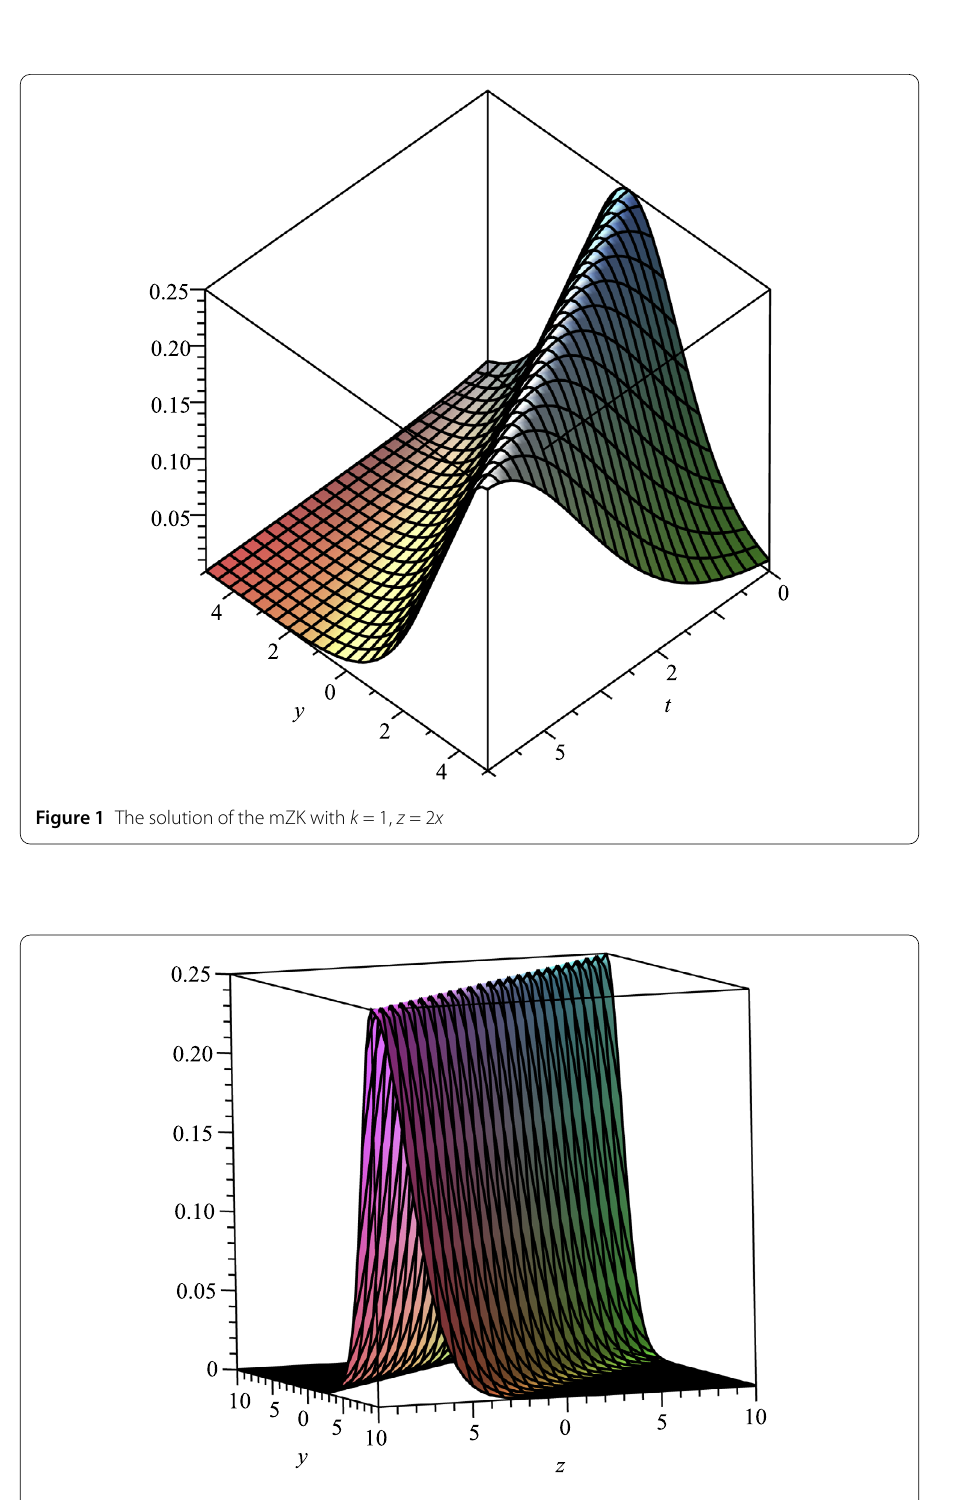
Figure 2 The solution of the mZK with k = 1, t = –2 x